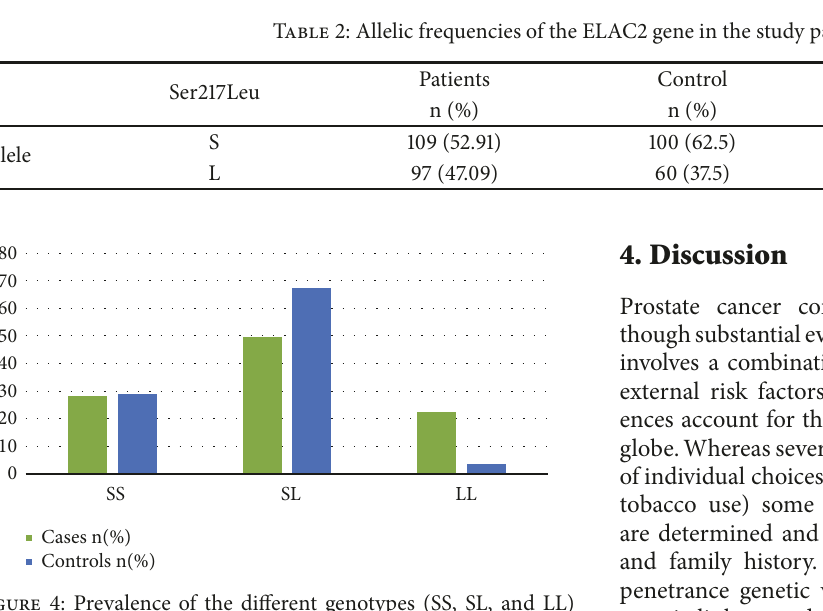
presence of two copies of the mutant allele (LL) confers a high risk of developing prostate cancer (p-value =